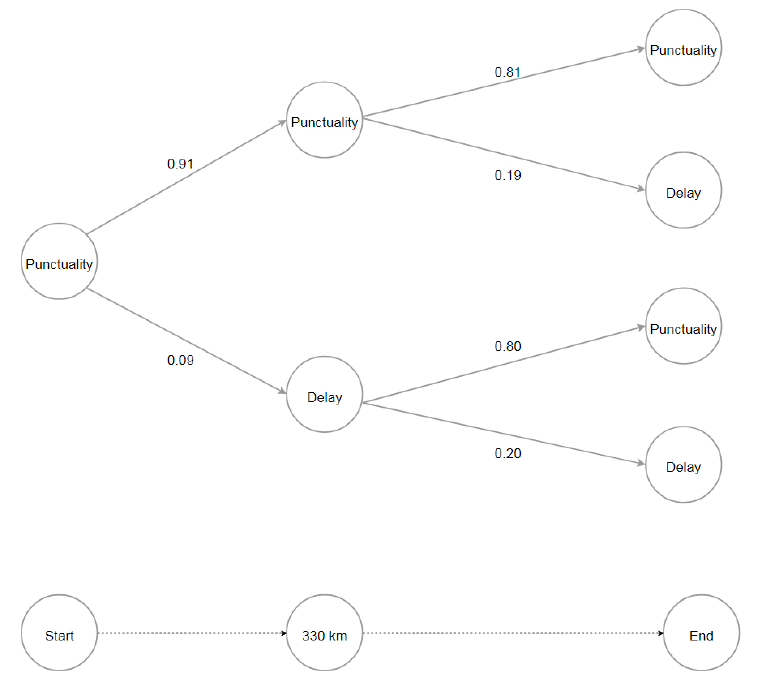
Figure 5. Probabilities of evolution of delayed status in the